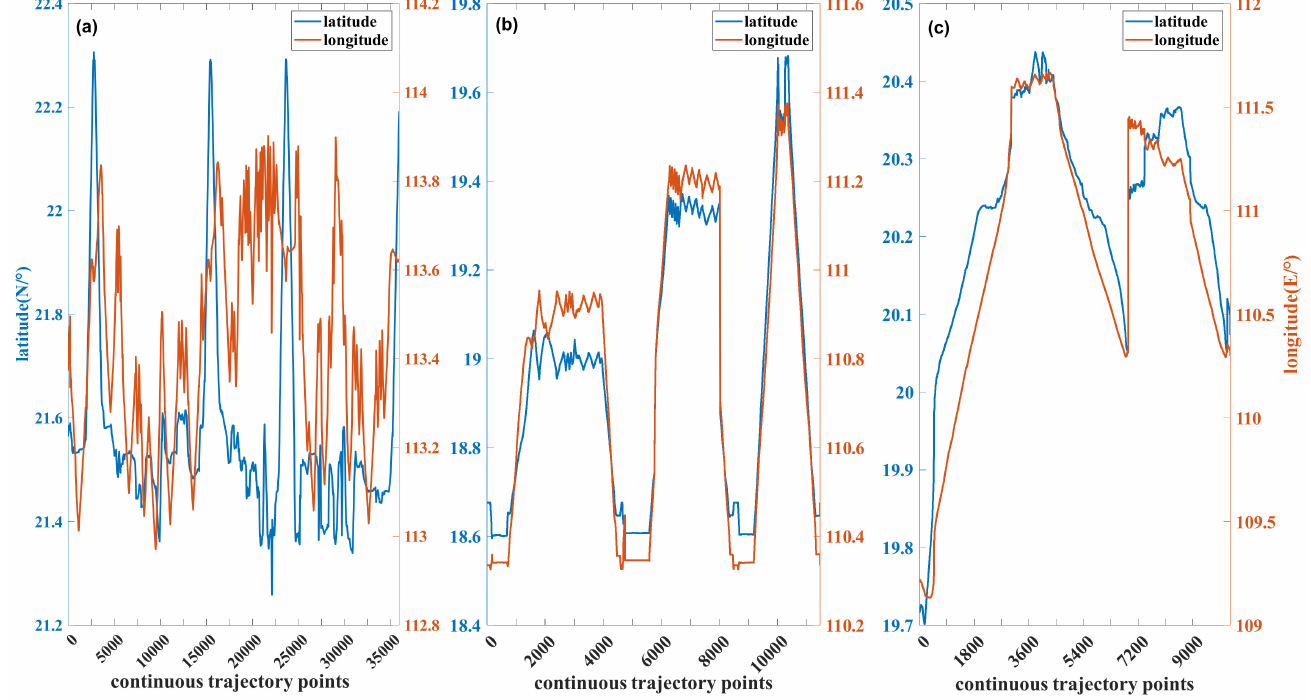
Figure 7. Latitude and longitude change curves of a trawler ( a ), gillnetter ( b ), and seiner ( c